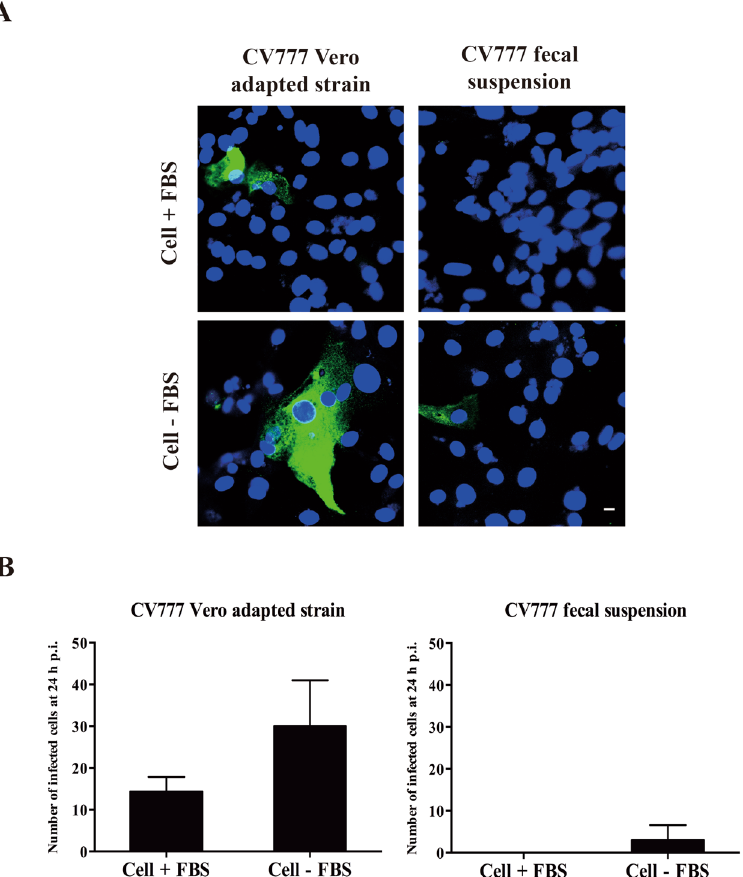
Figure 9. Infection of ileum epithelial cells co-cultured with myofibroblasts with PEDVCV777. Twenty- four hours post isolation, cells were refreshed with culture medium with/without FBS. Three days post co- cultivation, cells were inoculated with PEDV CV777 Vero adapted strain containing 10 4.9 CCID50 or with fecal material containing 10 7 viral RNA copies/ml of wild type CV777. Twenty-four hours post inoculation, the infection was visualized by immunofluorescence staining ( A ) and the total number of infected epithelial cells in a 24 well plate was determined ( B ). Scale bar: 10 µ m. Data are expressed as mean ± standard deviation of the results of 3 separate